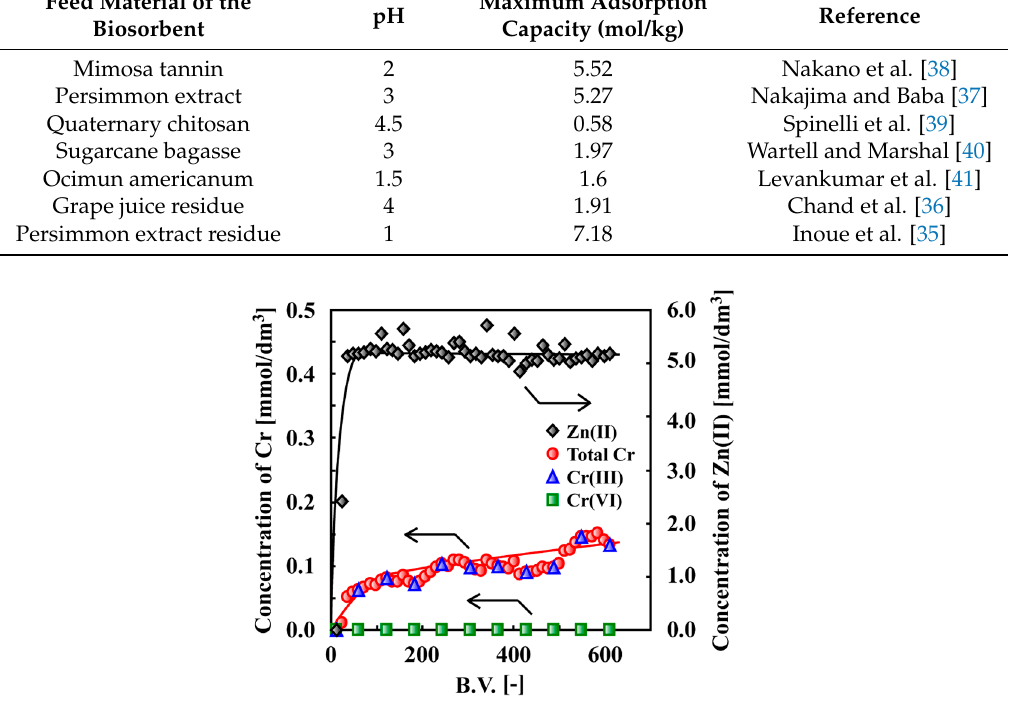
Figure 39. Zn(II) and Cr species breakthrough profiles for a column packed with crosslinked persimmon gel at pH = 1. Weight of packed gel = 150 mg, feed concentration of Cr(VI) = 0.5 mM, that of Zn(II) = 5 mM, flow rate = 6.5 mL/h [35]. (With permission for reuse from Elsevier B.V.).